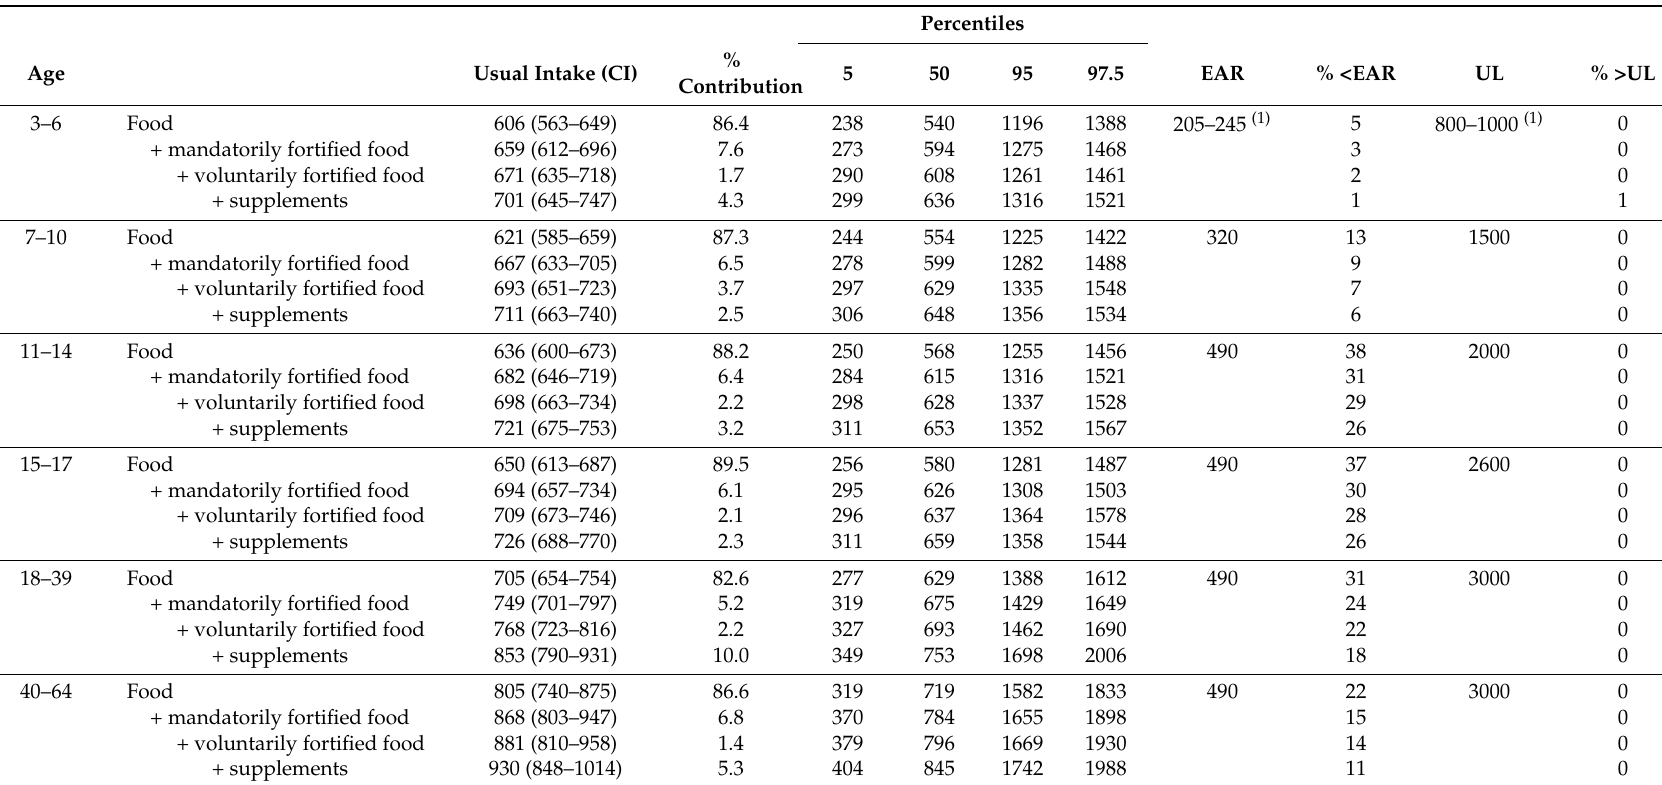
Table 4. Usual intake of vitamin A ( µ g/day) from food, fortified food and supplements in Belgian women (3–64 years), Belgian study on the intake of vitamins A, D, E and K (VITADEK-study)